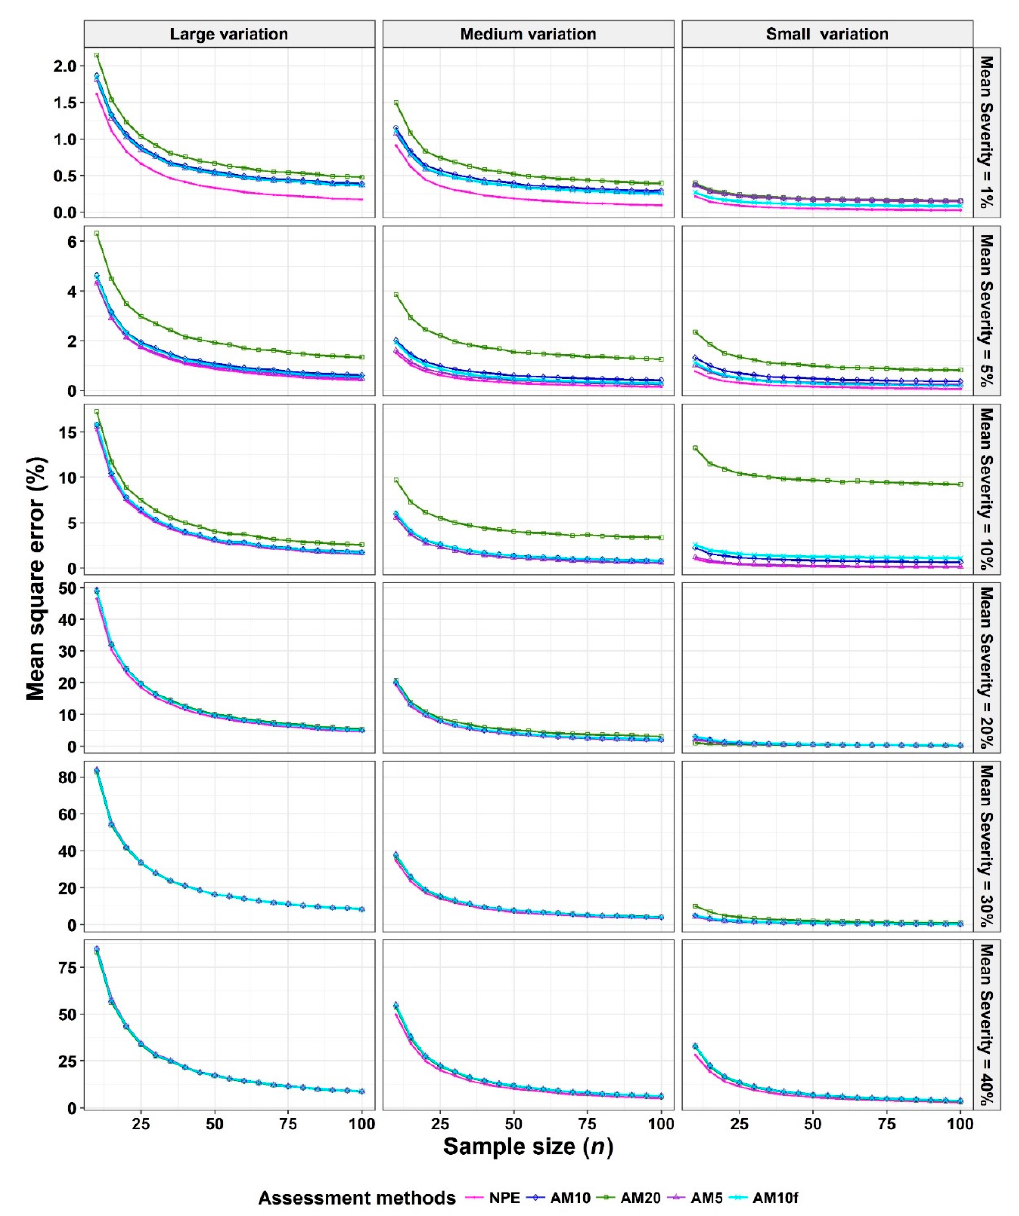
Figure 5. The relationships between the mean squared error (MSE) of mean disease severity estimates and sample size ( n ) (from n = 10 to 100 in n = 5 increments) for each of the different scales used, over a range of “actual” mean disease severities (1%, 5%, 10%, 20%, 30%, and 40%) and variance (represented by large, medium, and small variation). The simulation process was repeated 10,000 times. Assessment methods: (i) NPE (nearest percentage estimate); (ii) AM10 (10% linear scale emphasizing severities ≤ 50% disease, and with additional intervals at severities < 10%); (iii) AM20: similar to the structure of AM10 (both scales have the same structure at ≤ 10%), but with 20% intervals for disease severities from 10% to 50%; (iv) AM5: similar to the structure of AM10 (both scales have the same structure at ≤ 10%), but with 5% intervals for disease severities 10 to 50%; and (v) AM10f: similar to the structure of the AM10 scale, but with finer intervals at ≤ 10% disease.